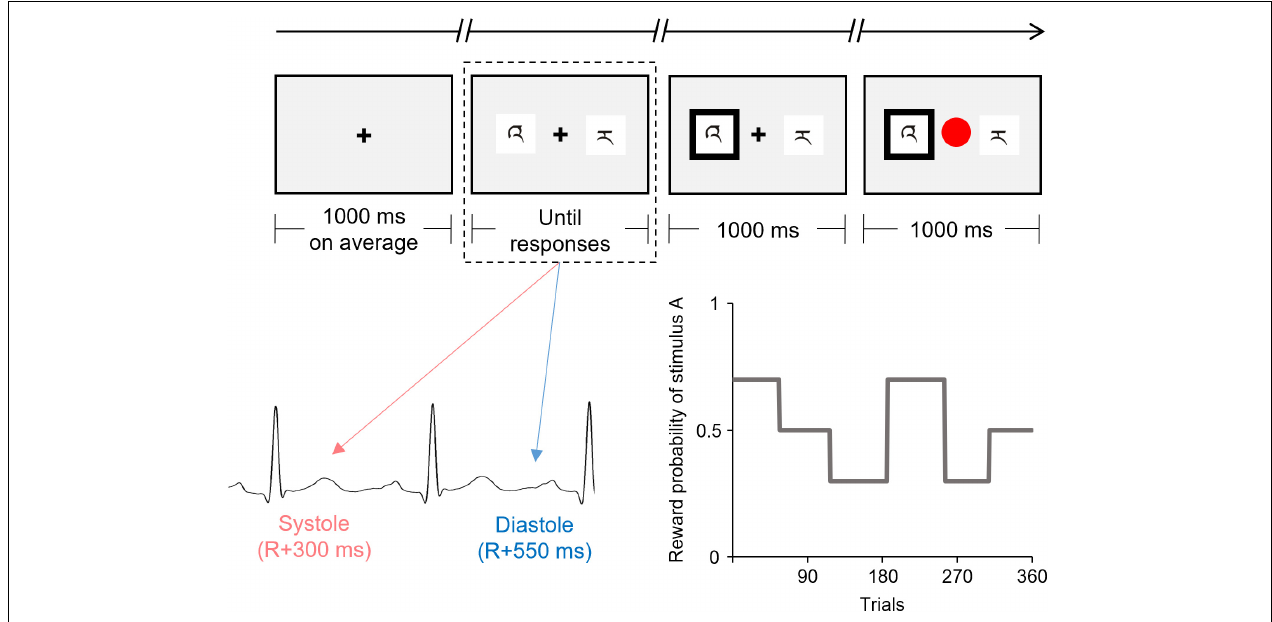
FIGURE 1 | Schematic illustration of the flow of one trial of the instrumental learning task. The presentation of the discriminative stimuli (indicated by the dashed line) was experimentally manipulated to coincide with either the cardiac systole or diastole. This figure shows the reward probability for one of the two discriminative stimuli (stimulus A) which was changed among six blocks according to the pre-determined